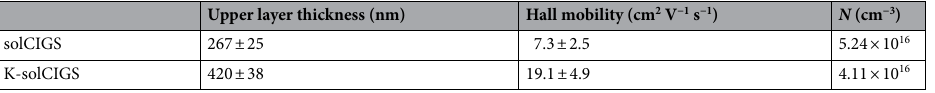
Table 1. Summary of upper layer thickness, Hall mobility, and charge carrier density ( N ) estimated by SEM analysis, and Hall effect and C ‒ V measurements, respectively.